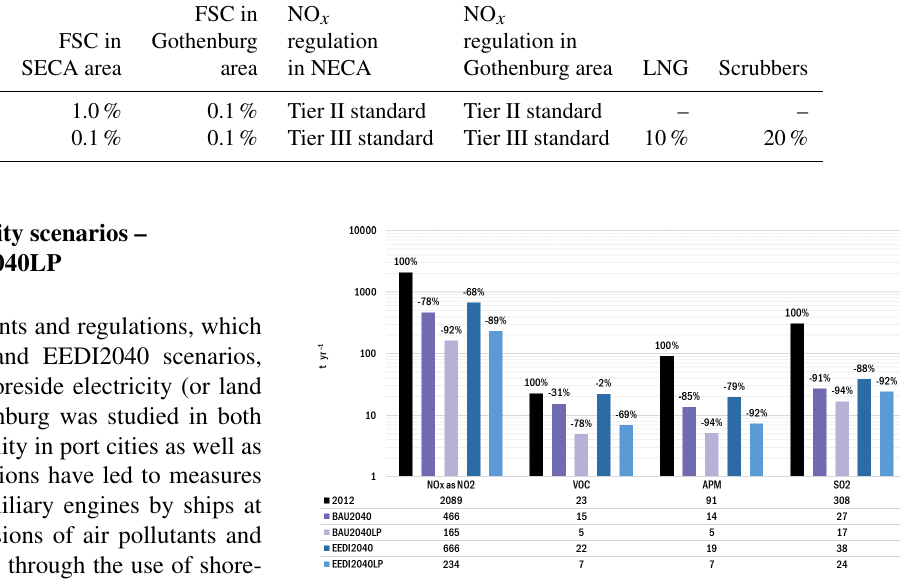
Figure 4. Annual shipping emissions of NO x , VOC, PM 10 , and SO 2 for the local CTM simulation in Gothenburg for 2012, BAU2040, and BAU2040LP emissions